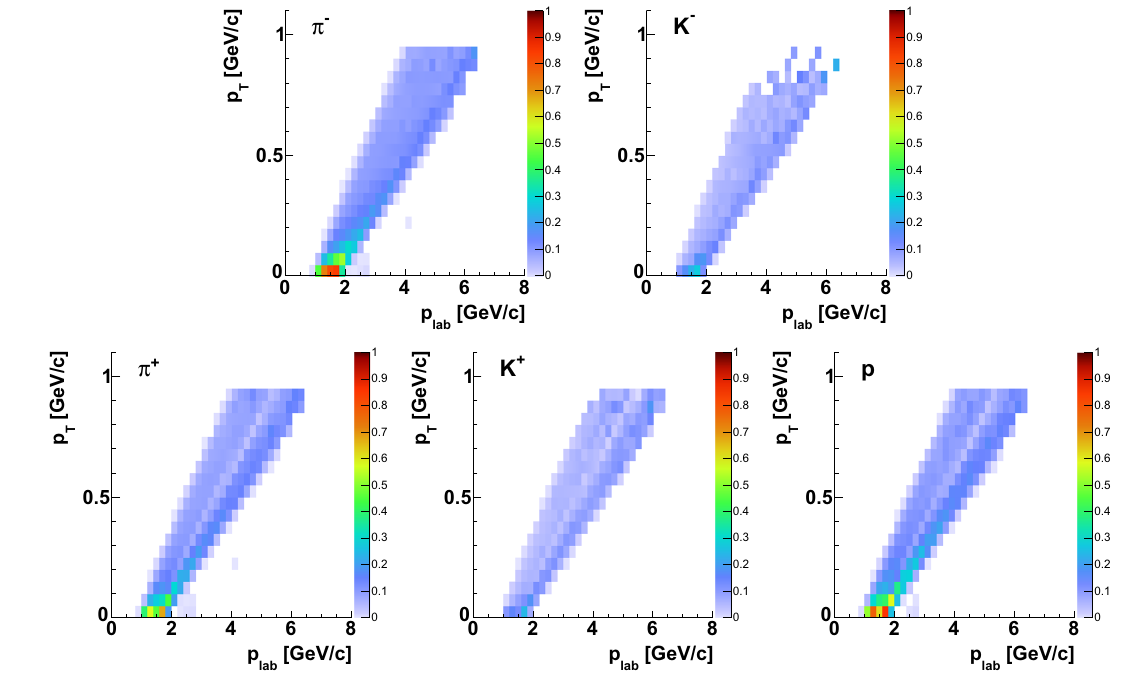
Fig. 14 Efficiencies C tof for the tof -d E / d x identification method for positively and negatively charged pions, kaons and protons for p + p i interactions at 20 GeV / c